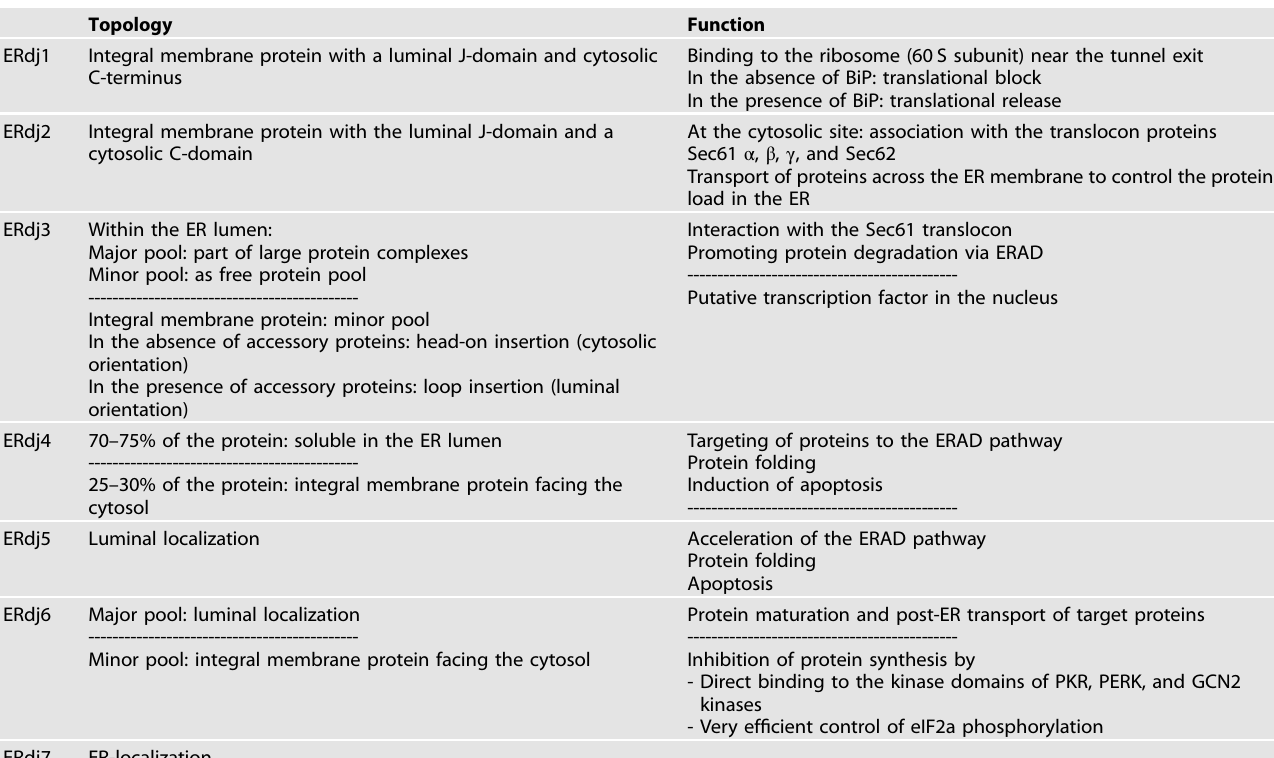
charged residues but is neighbored by two positively charged amino acids, in the absence of ERdj2 and BiP, ERdj3 indeed favors a head-on insertion into the translocon. As ERdj2/BiP dependency during translocation might be tightly linked to the topology of other proteins, it would be of interest to assess the ERdj2/BiP dependency of all the other ER J-proteins during their translocation into the ER. The signal sequence of ERdj4 is very similar to the one of ERdj3 in terms of the lack of charged residues as well as hydrophobicity as was assessed by